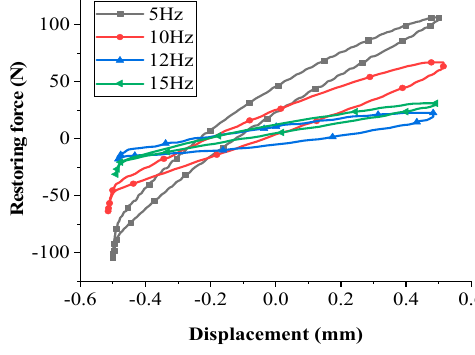
Figure 6. Hysteresis loop at different frequencies f (A = 0.5 mm).